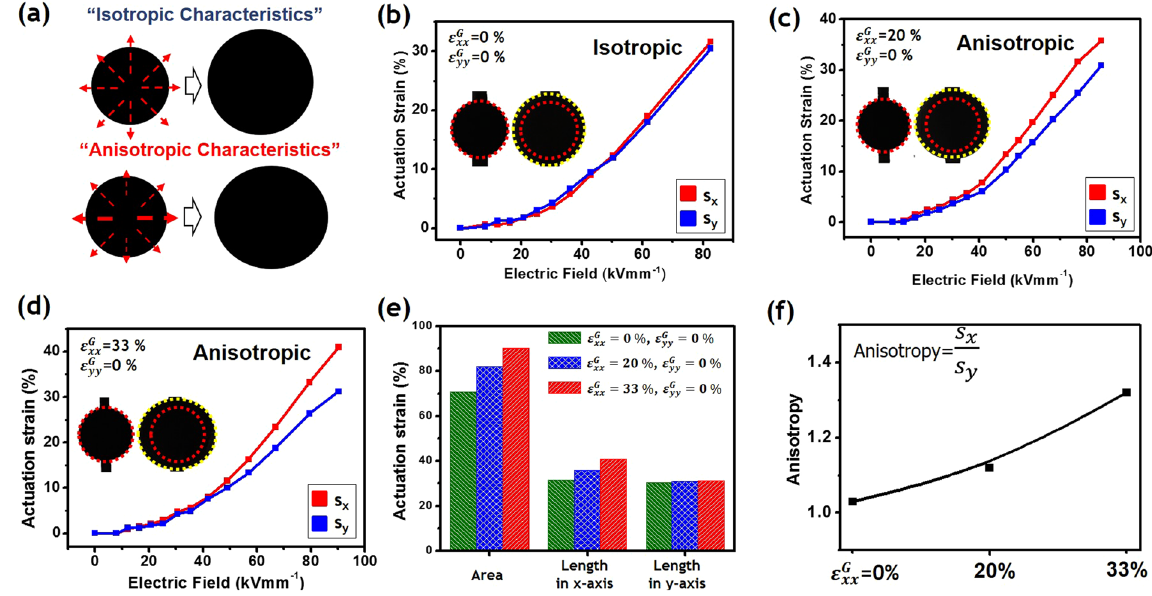
Figure 4. Macroscopic observation of wrinkled elastomer actuators: ( a ) concept of anisotropic actuation, ( b ) equibiaxially-prestretched elastomer actuator, ( c ) wrinkled elastomer actuator with ε xxG = 20% ( d ) wrinkled elastomer actuator with ε xxG = 33%, ( e ) maximum areal and directional strains with various levels of compressive strain, and ( f ) anisotropy value according to different compressive